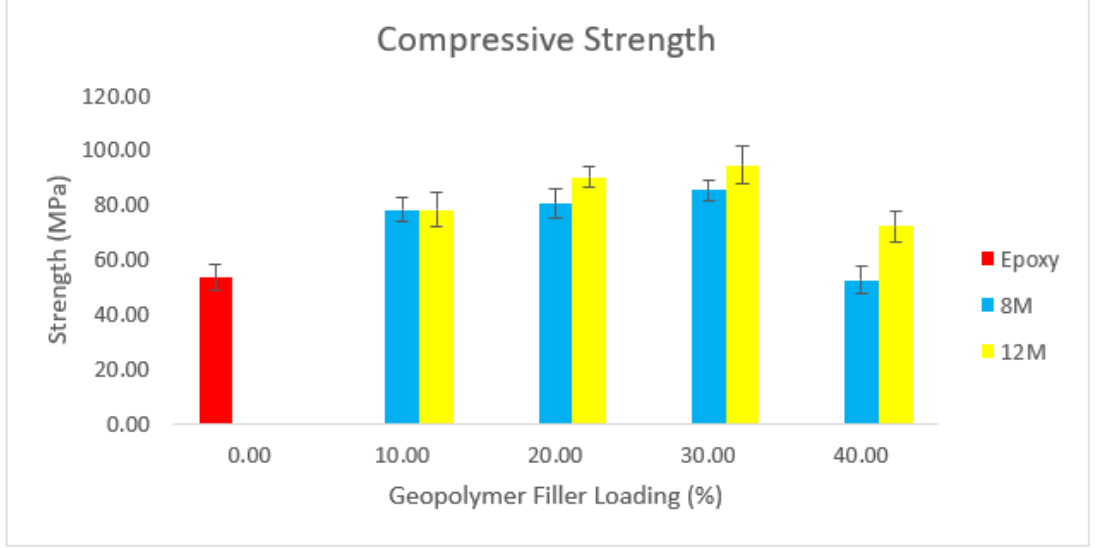
Figure 12. Compressive strength of GRE pipe with 0–40 wt% geopolymer filler loading. Table 4. Compression properties of GRE pipe without geopolymer filler and GRE filled with geopoly- mer